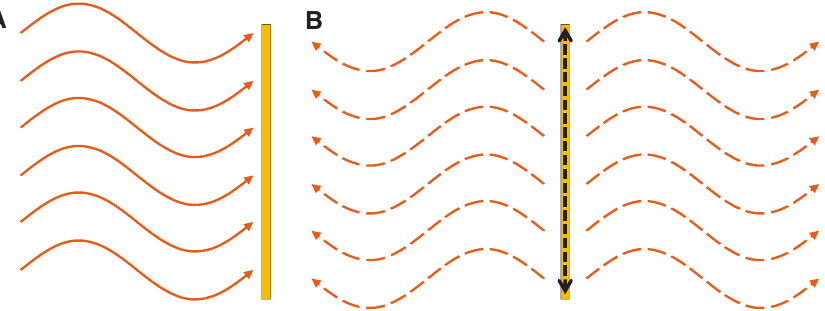
Figure 7: Re-radiation from a dipole antenna. (A) The antenna is excited by the incident wave; (B) The exited current re-radiates the energy forwards and